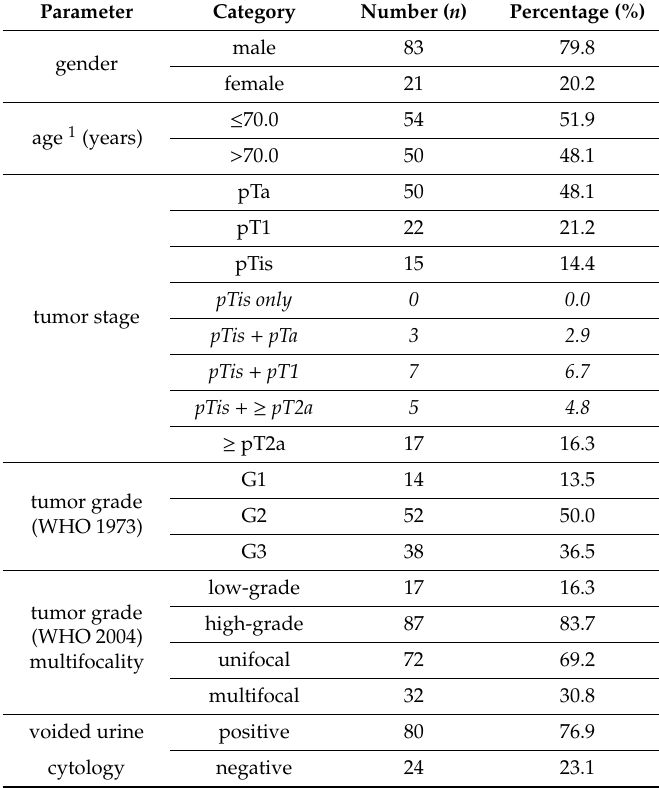
Table 1. Demographic, clinical, and histopathological characteristics of the BCa patients ( n = 104). The table shows the absolute and relative distribution of gender, age, and clinicopathological parameters.